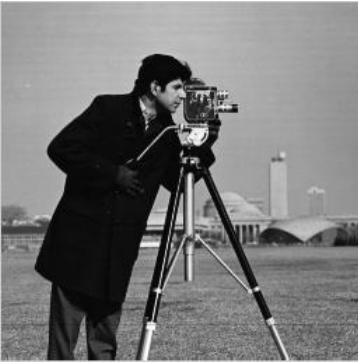
Figure 4. MATLAB cameraman image used for experiments and evaluation process.